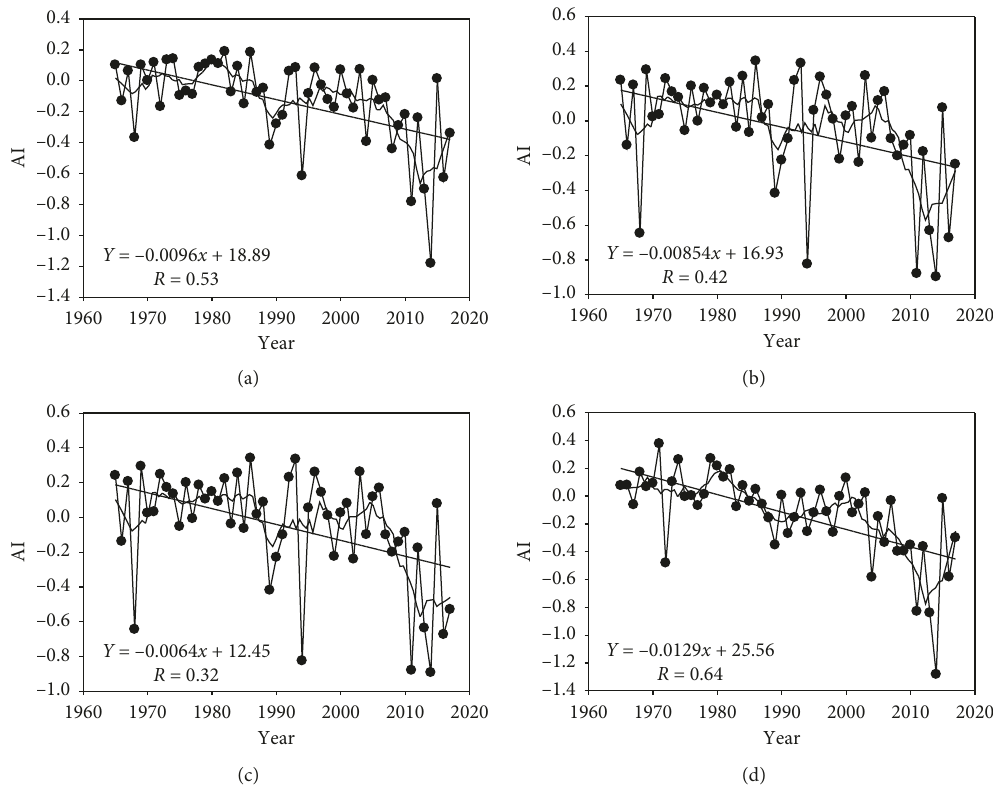
Figure 3: Areal average AI changes over Northeast China during 1965–2017. (a) Northeast China. (b) Liaoning. (c) Jilin. (d)